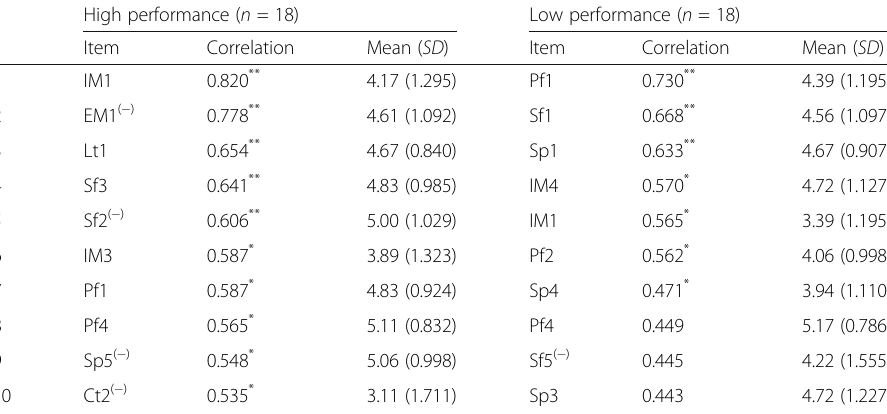
Table 4 Top ten correlation values based on intention to continue shadowing High performance ( n = 18) Low performance ( n = 18) Item Correlation Mean ( SD ) Item